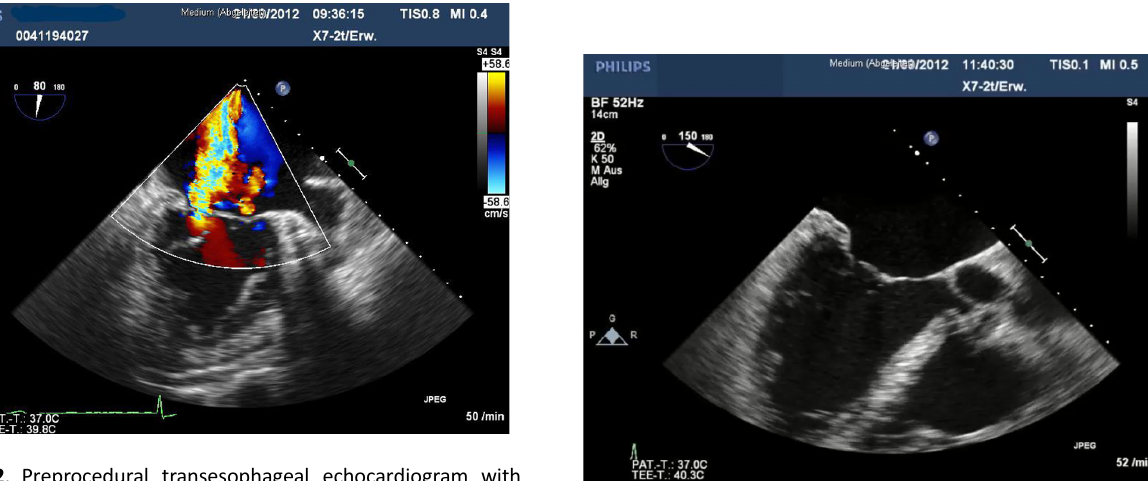
Supplementary Video 1 . Trans-esophageal three chamber view with pull out of the anterior lea fl et.